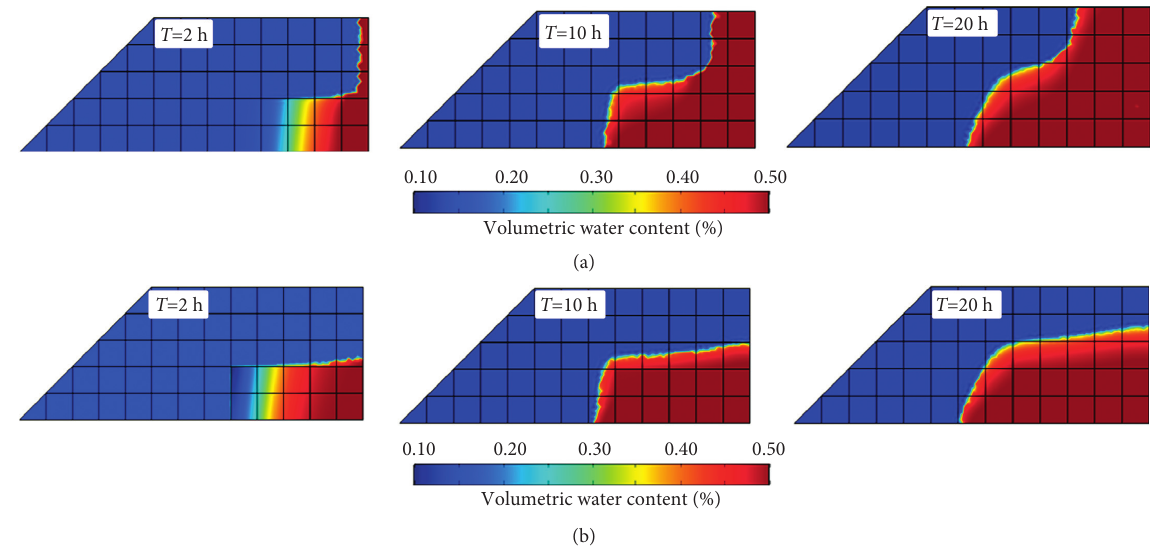
Figure 12: Variation of the water content with time obtained by the dual-permeability model. (a) In the soil matrix domain. (b) In the preferential flow